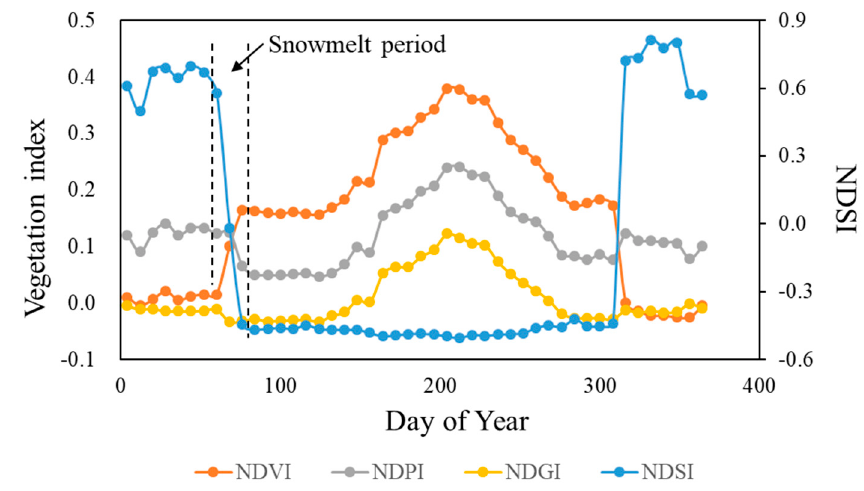
Figure 2. An example showing an annual time series of normalized difference vegetation index (NDVI), normalized difference phenology index (NDPI), and Normalized Difference Snow Index (NDSI). NDSI was found to dramatically decrease during snowmelt period in spring. This example was selected from the area in Mongolia (46 ° N, 113 ° E).